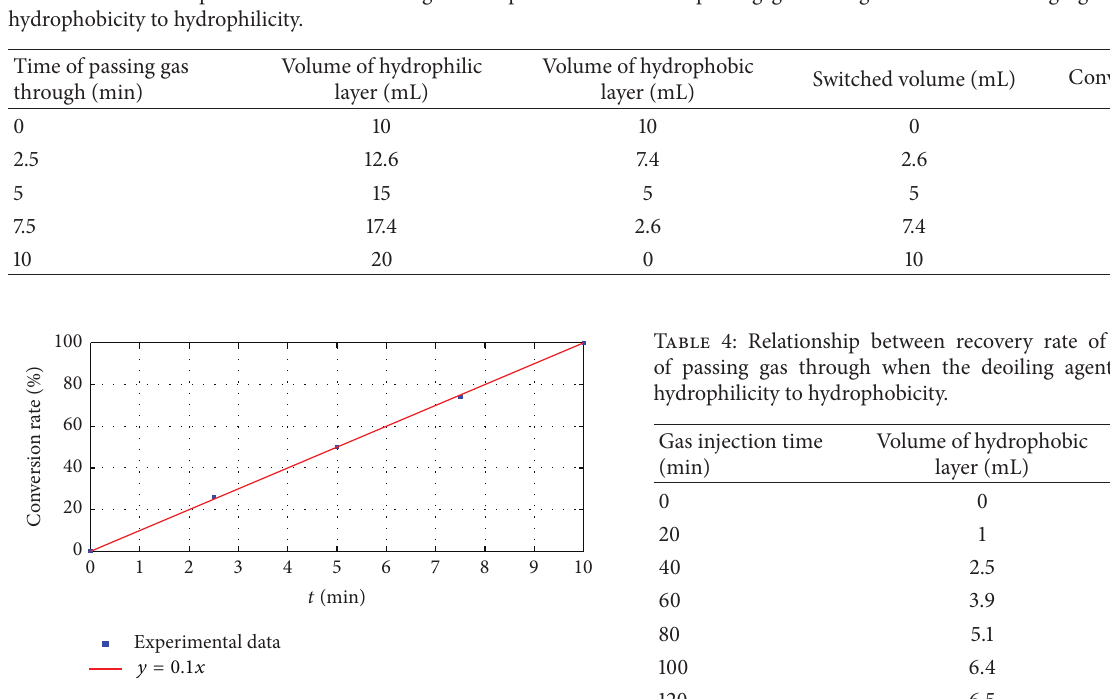
Figure 3: The fitting curve of the relationship between conversion rate of SDA and the time of passing gas A through.